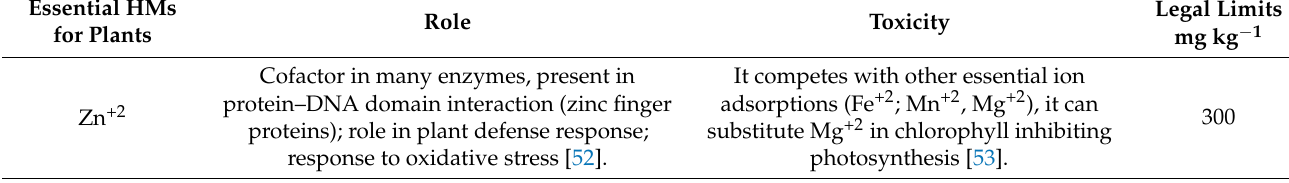
Table 1. Heavy metals (HMs), which are micro-essential nutrients for plants but toxic in excessive concentrations. The roles and toxicity of zinc, copper, iron and nickel are reported. The legal limits refer to agricultural soils in accordance with Italian Decree 46/2019. Currently, at the EU level, there is no Directive on soil. Essential HMs Role Toxicity for Plants